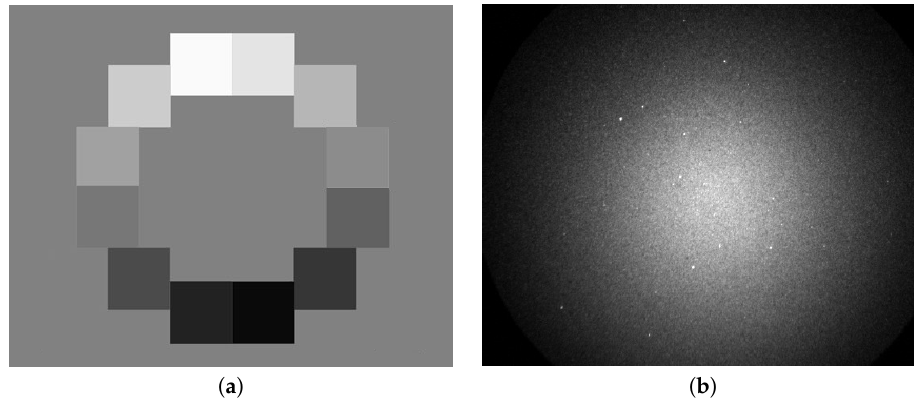
Figure 4. Examples of input data. ( a ) ISO 14524 test chart. ( b ) Real image